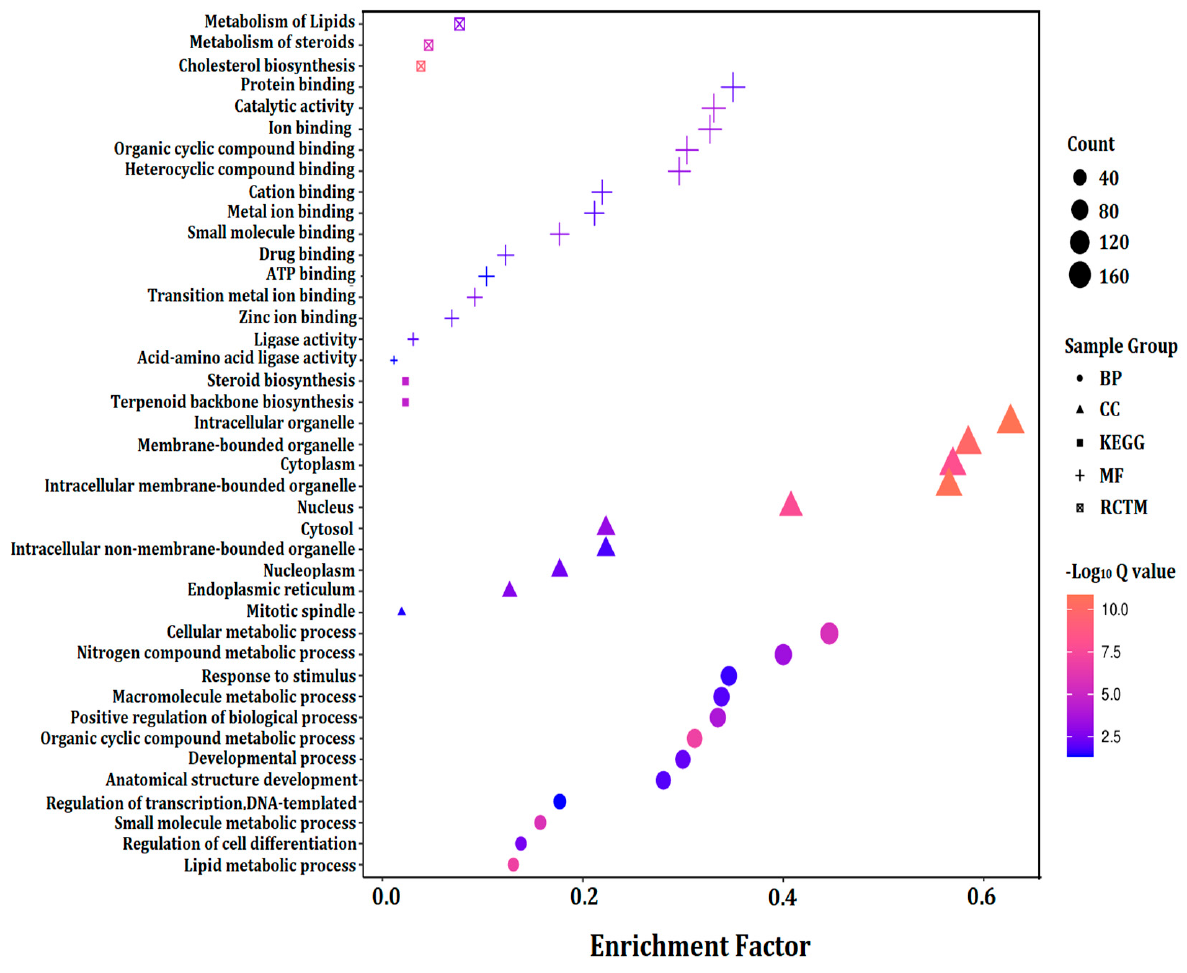
Figure 6. Enrichment of GO, KEGG, and Reactome of significantly expressed genes with fold change ≥ 5. The significantly expressed genes (fold change ≥ 5) in 40-day expo and 60-day expo Balb/c-3T3 cells were analyzed by gene ontology (GO), KEGG, and Reactome pathways. BP: biological process; CC: cellular component; MF: molecular function; KEGG: Kyoto encyclopedia of genes and genomes pathway; RCTM: Reactome protein.